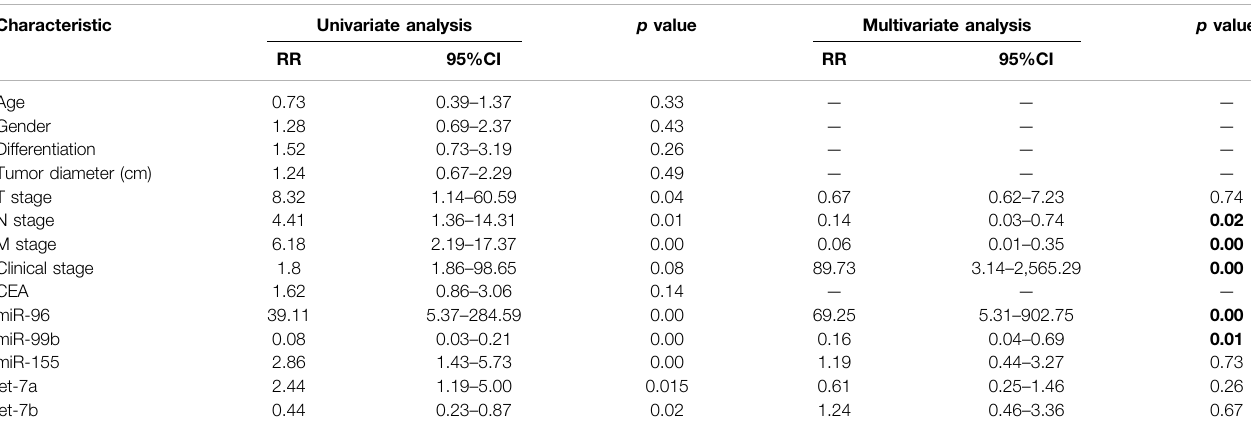
TABLE 4 | Univariate and multivariate analyses for overall survival of CRC patients with liver metastasis. Characteristic Univariate analysis p value Multivariate